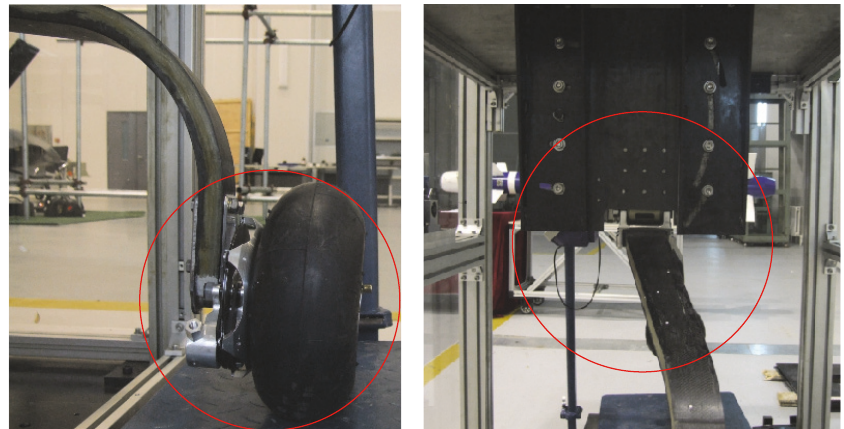
Figure 11: Setup of drop tests.